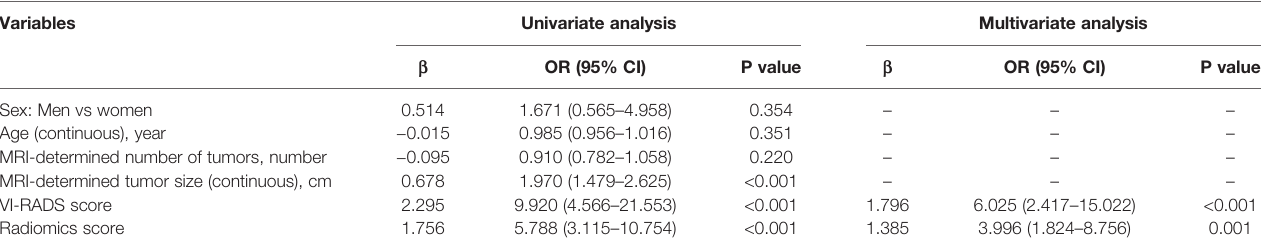
TABLE 2 | Univariate and multivariable regression analyses of the radiomics score and clinical factors in the training cohort. Variables Univariate analysis Multivariate analysis b OR (95%